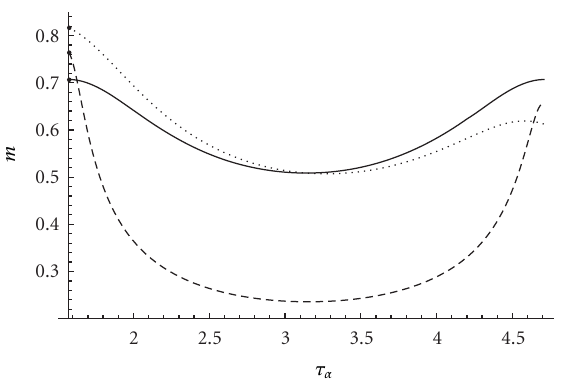
Figure 5: Function m of (cid:4) 4.15 (cid:5) in the interval (cid:4) π/ 2 , 3 π/ 2 (cid:5) when (cid:4) | α | 2 , Δ (cid:4) 0 (cid:5) (cid:5) (cid:8) (cid:4) 0 . 5 , 0 (cid:5) (cid:4) solid (cid:5) , (cid:4) | α | 2 , Δ (cid:4) 0 (cid:5) (cid:5) (cid:8) (cid:4) 0 . 5 , 0 . 3 (cid:5) (cid:4) dotted (cid:5) , and (cid:4) | α | 2 , Δ (cid:4) 0 (cid:5) (cid:5) (cid:8) (cid:4) 20 , 0 . 9 (cid:5) (cid:4) dashed (cid:5) ; both σ set to the